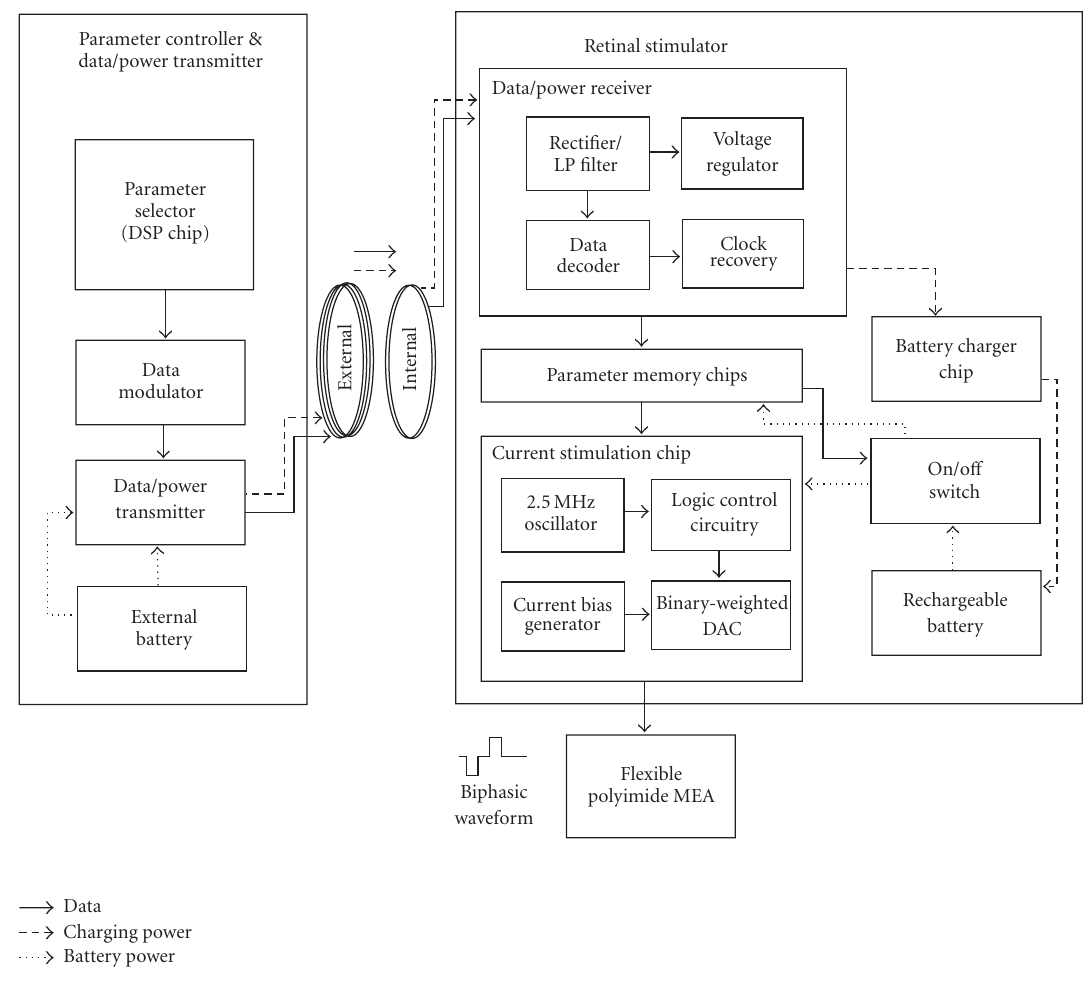
Figure 1: System block